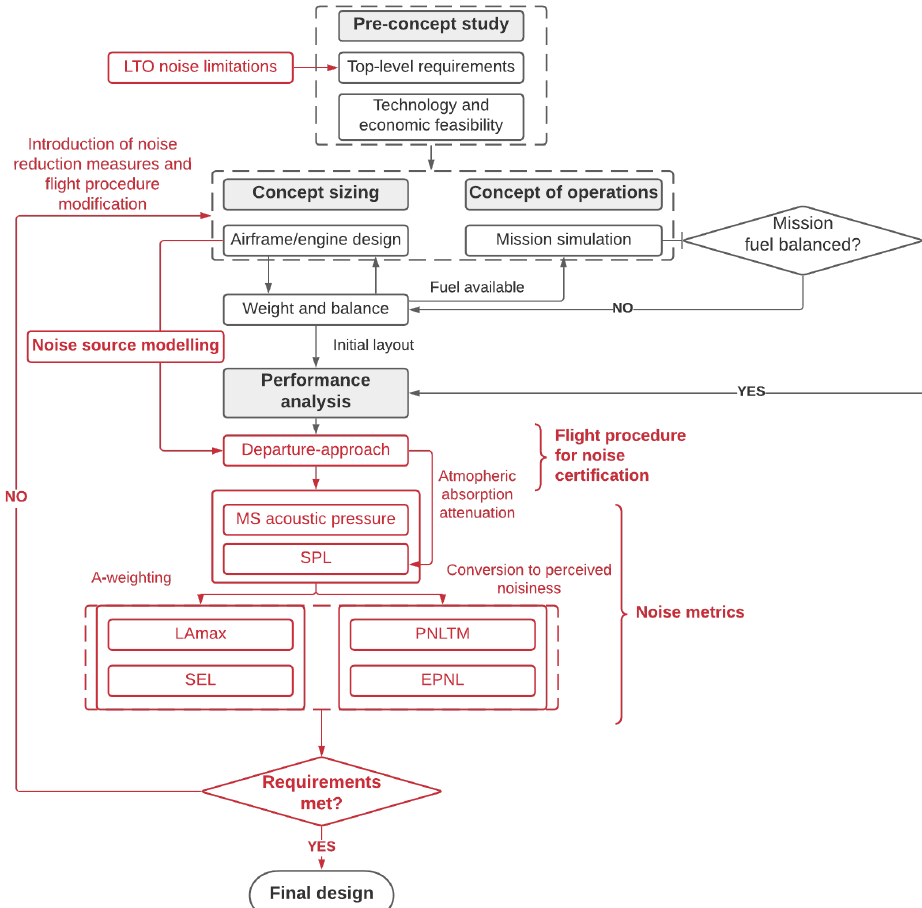
Figure 2. Overall methodology framework supporting a design-to-noise